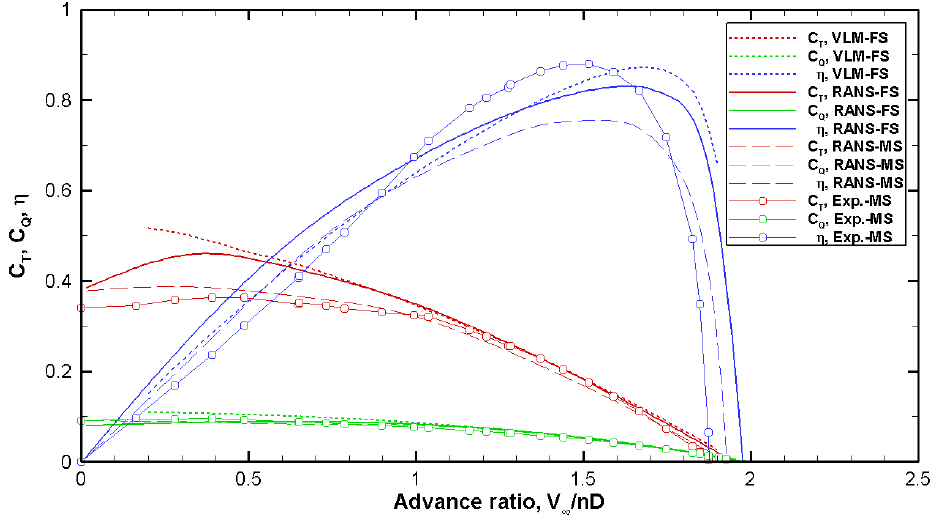
Figure 14. Propeller-performance curve for pitch angle = 39°.